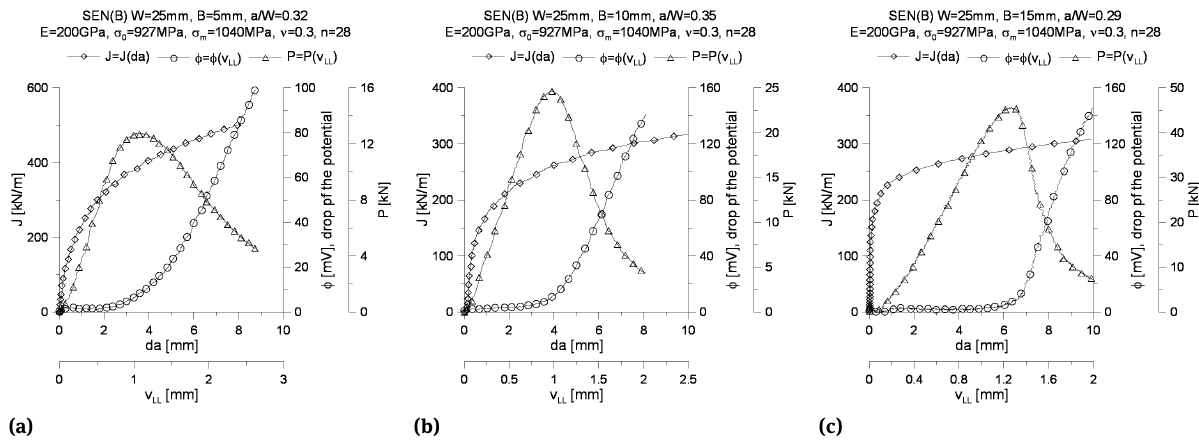
Figure 3: List of signals (quantities) registered during experimental tests ( φ = φ ( v LL ) , P = P ( v LL ) ) and determined J - R curves ( J = J ( da )) for three SEN(B) specimens made of 145Cr6 steel: a) B = 5mm, a / W = 0.32 ; b) B = 10mm, a / W = 0.35 ; c) B = 15mm, a / W = 0.29 ; (based on